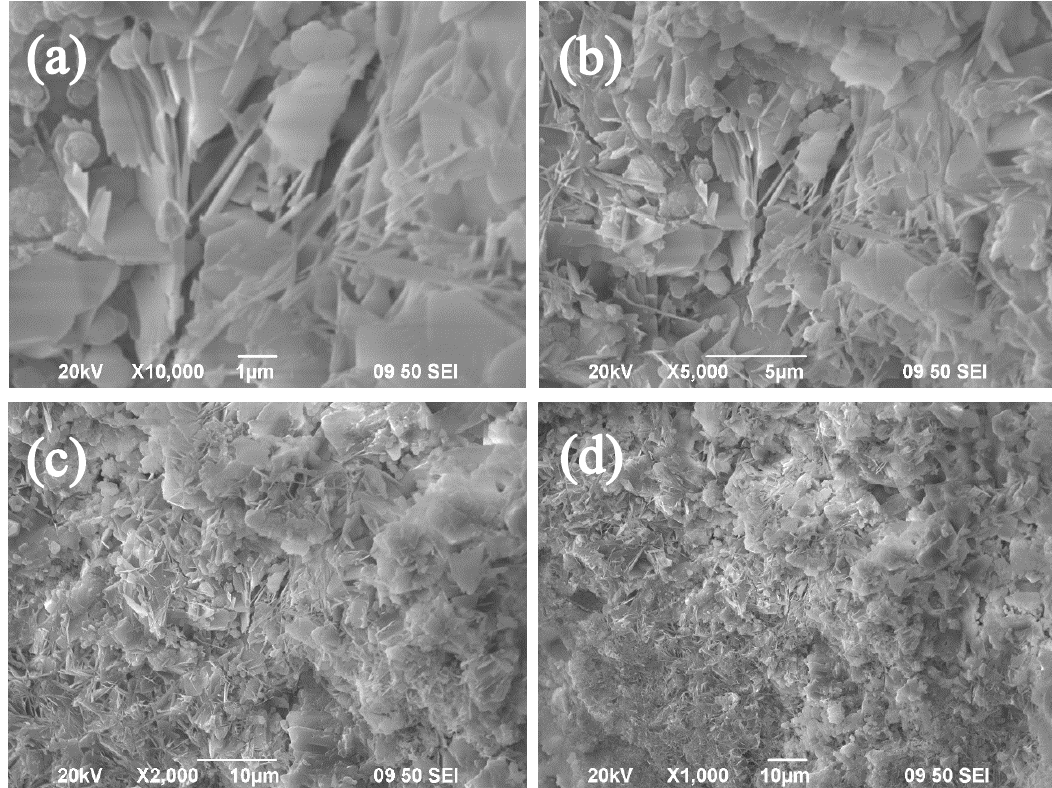
Figure 2. SEM photographs of the aerated brick at different magnifications: ( a ) ×10000; ( b ) ×5000; ( c ) ×2000; ( d ) ×1000.